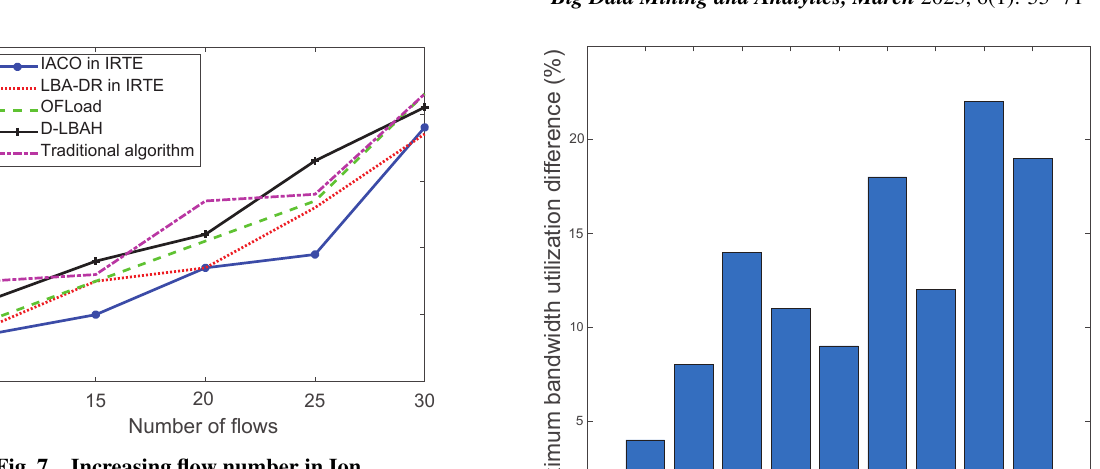
Fig. 7 Increasing flow number in Ion.